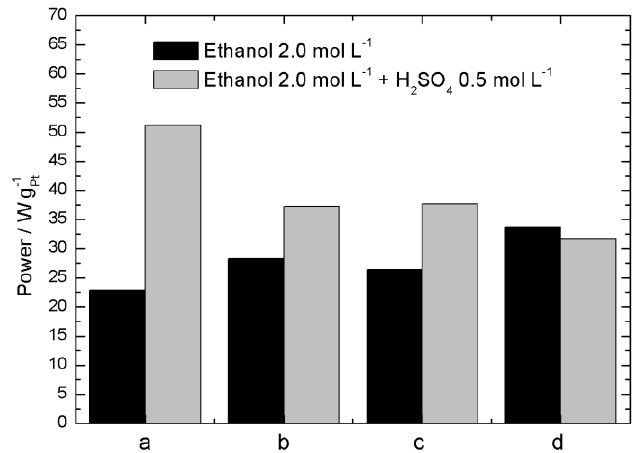
Figure 7. Normalized maximum power values obtained by mass of platinum in the ethanol fuel cell test for the catalysts under different conditions. (a) Pt 63 Sn 13 Ta 24 /C; (b) Pt 50 Sn 21 Ta 25 Ru 4 /C; (c) Pt 60 Sn 15 Ta 18 Ru 7 /C; (d) Pt 75 Sn 12 Ta 6 Ru 7 /C.